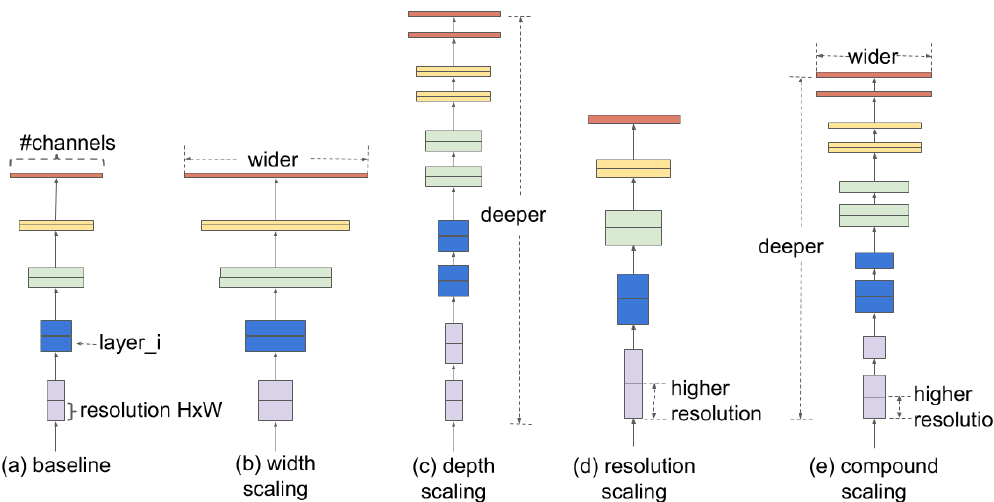
Figure 2. Model Scaling. (a) is an example of a baseline network; (b)-(d) are conventional scaling that only increases one dimension of network, width, depth or resolution. (e) uniformly scales all three dimensions with a fixed ratio. [10]